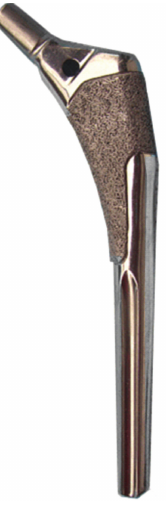
Figure 1: The Anatomic Fiber Metal plus stem.